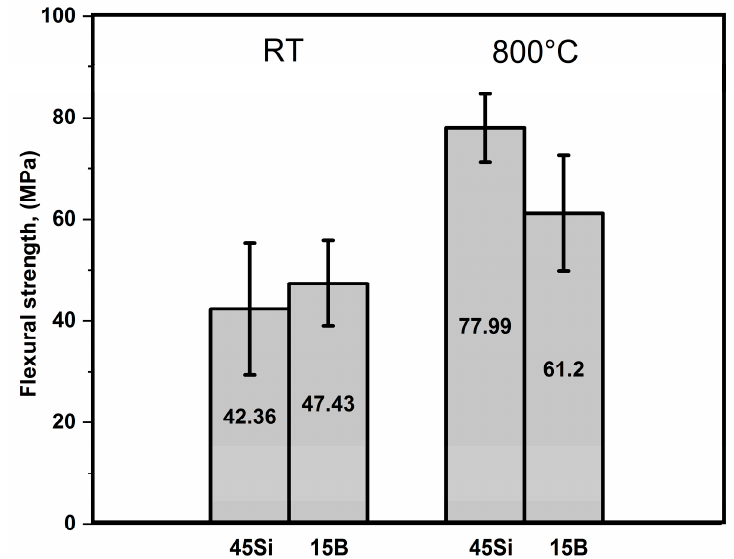
Figure 5. Flexural strength of 45Si and 15B + 25Si samples at room temperature (RT) and 800 °C in air. The average bending strength of 45Si and 15B + 25Si samples at room temperature are 42.36 MPa